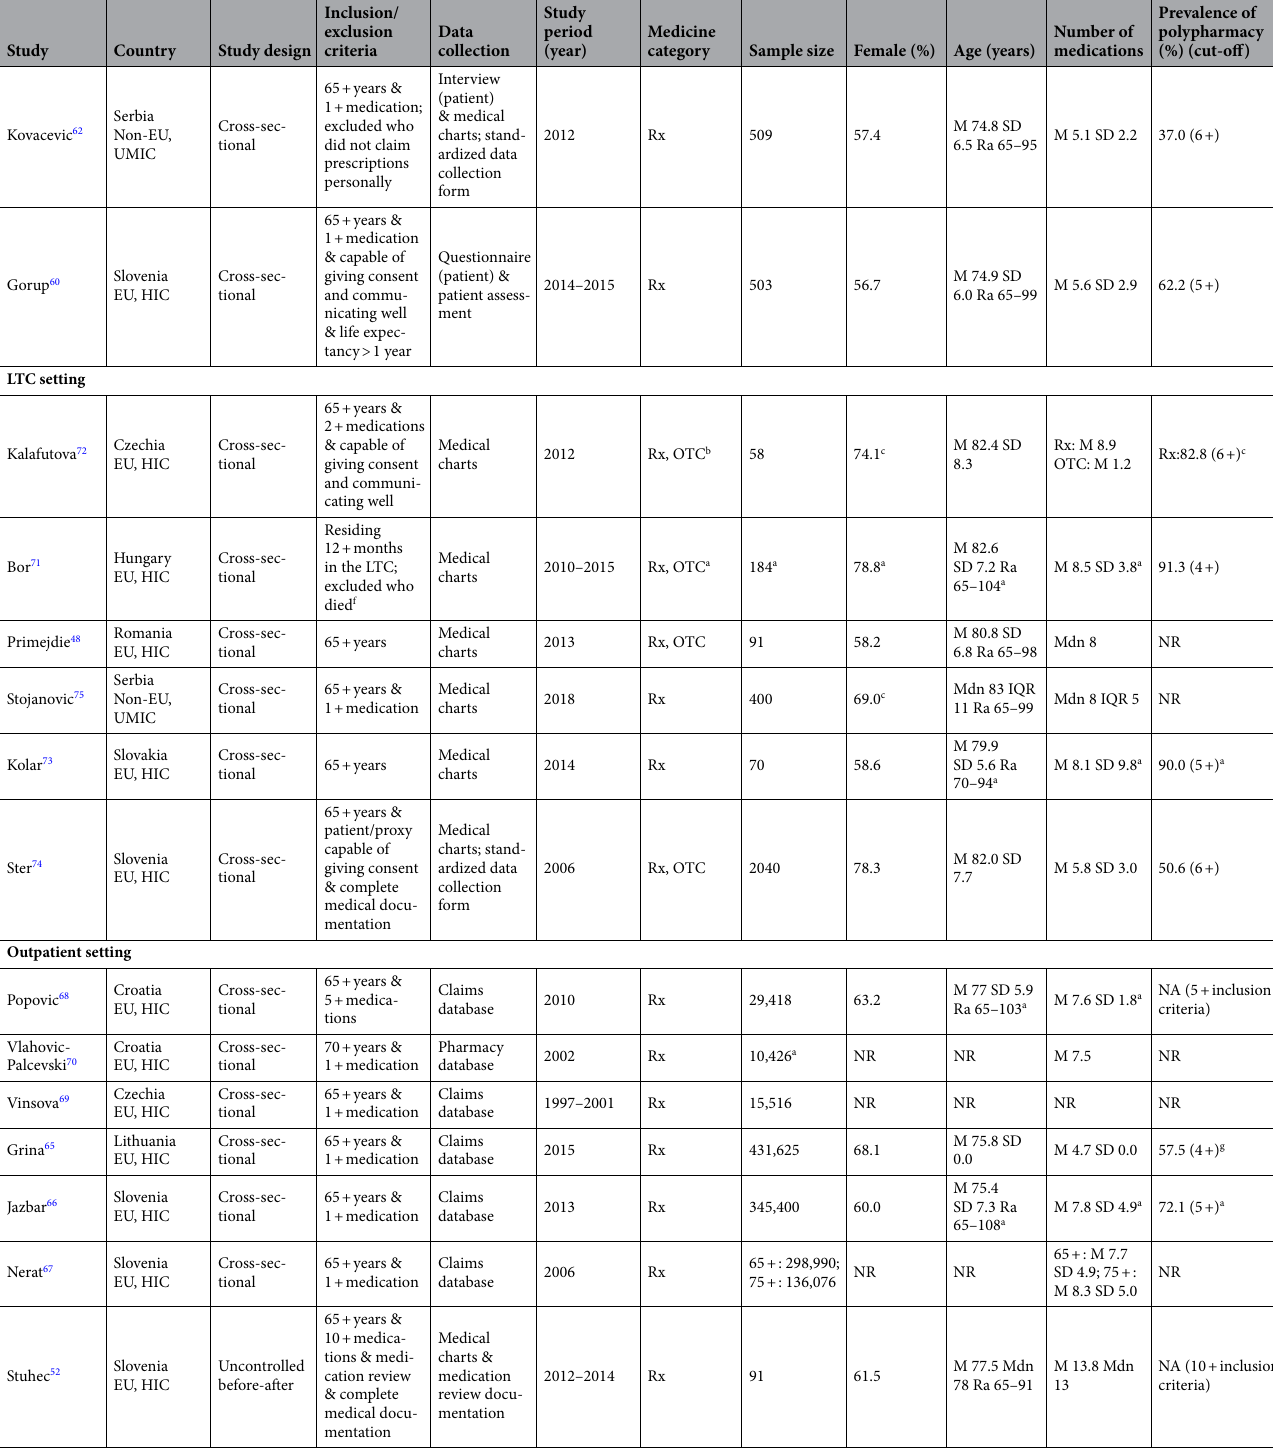
Table 1. Characteristics of included studies. EU European Union, GP General practitioner, HIC High-income country, IQR Interquartile range, LTC Long-term care, M Mean, Mdn Median, NR Not reported, OTC Over- the-counter medication, Ra Range, Rx Prescription medication, Sd Standard deviation, UMIC Upper-middle- income country. *Indicates the major publication for the study (the study was described in three reports). °One report described two studies. a Data were obtained and/or confirmed from study authors. b Dietary supplements were also included. c Calculated. d InterRAI Minimum Data Set for Home Care instrument, MDS-HC 76 . e Data were obtained from publication by Sikora et al . 77 . f Data for persons aged 65 + years were obtained by correspondence. g Discrepancies in publication resolved in